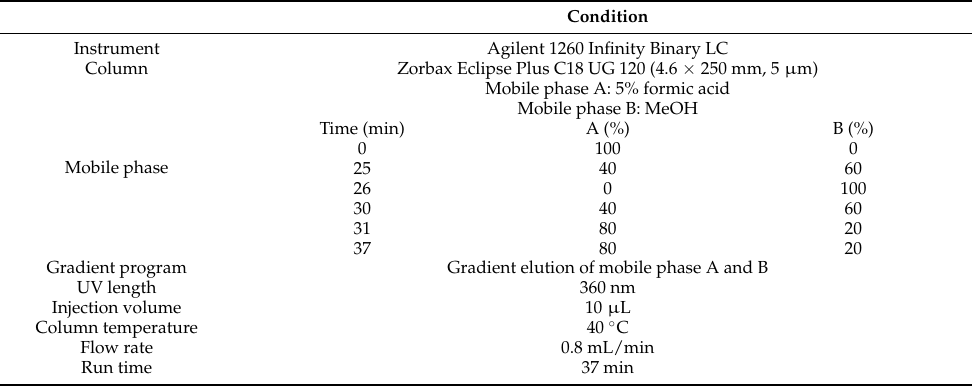
Table 1. HPLC condition for quercetin